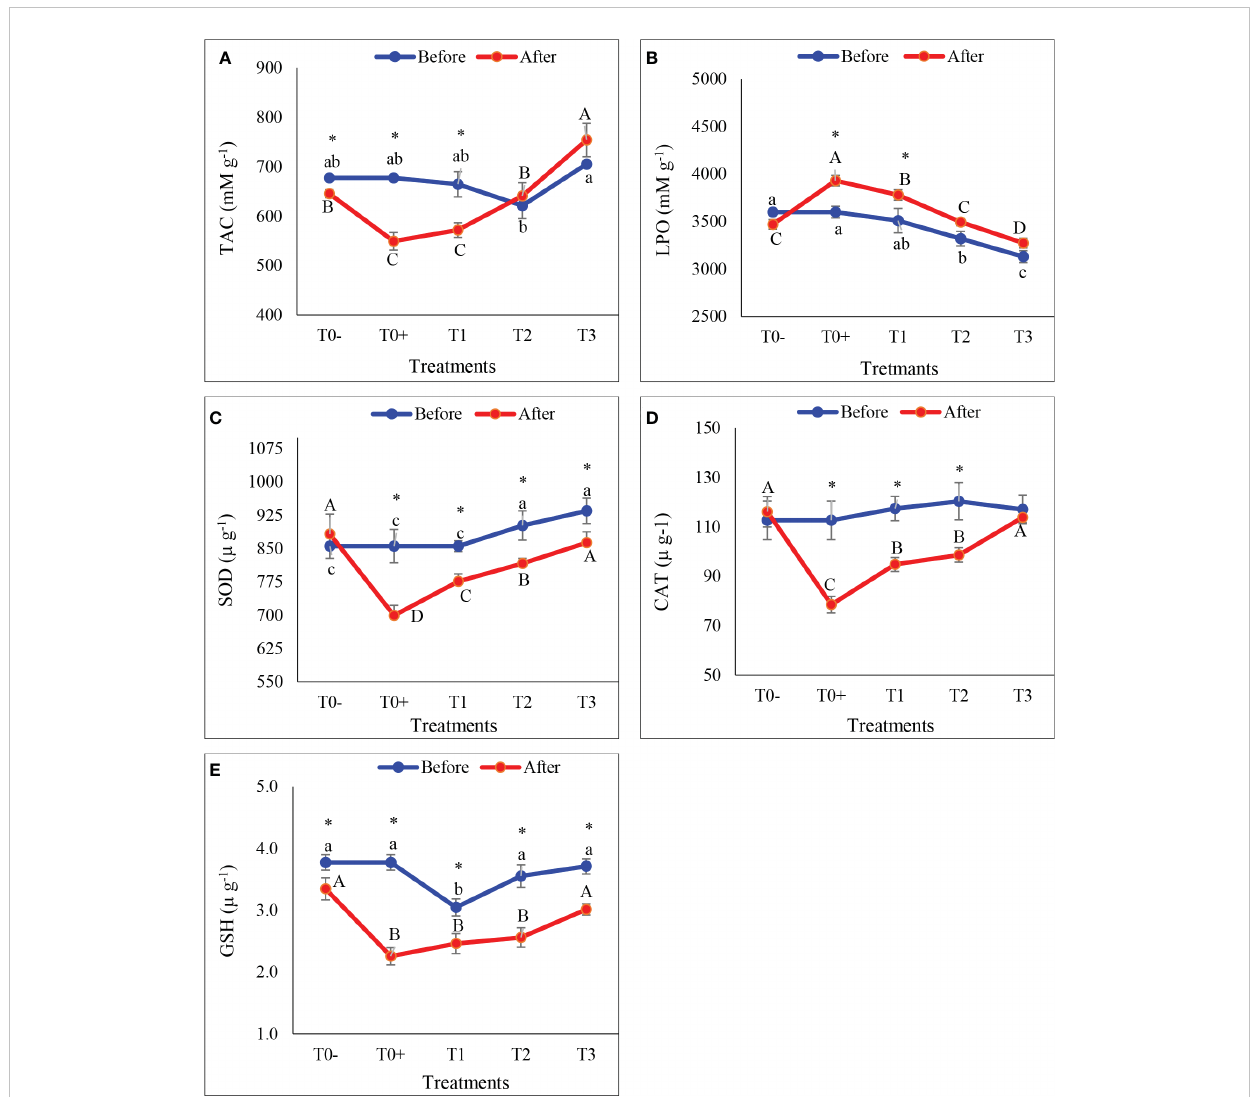
FIGURE 6 The hepatic total antioxidant capacity ( A : TAC), lipid peroxidase ( B : LPO), superoxide dismutase ( C : SOD), catalase ( D : CAT, and glutathione ( E : GSH) of red tilapia fed different ratios of corn oil (CO): Aquafat-O ® (AQ-O) and exposed to cold stress. T 0- (the negative treatment), T 0+ (the positive treatment), T 1 (2 CO: 1 AQ-O), T 2 (1 CO: 2 AQ-O), T 3 (3 CO: 0 AQ-O). Vertical bars indicate the standard errors; mean with an asterisk indicate a signi fi cant difference between before and after the exposure to cold stress ( p < 0.05). Small and capital letters indicate signi fi cant differences among treatments before and after the exposure to cold stress,